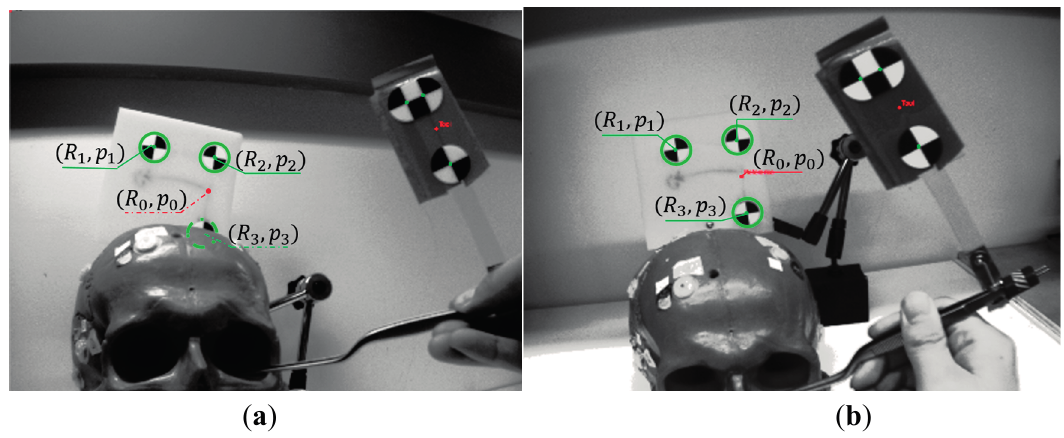
Figure 5. View of the stereo camera. ( a ) Only two marker points are captured during partial occlusion condition; ( b ) All of the marker points are captured without